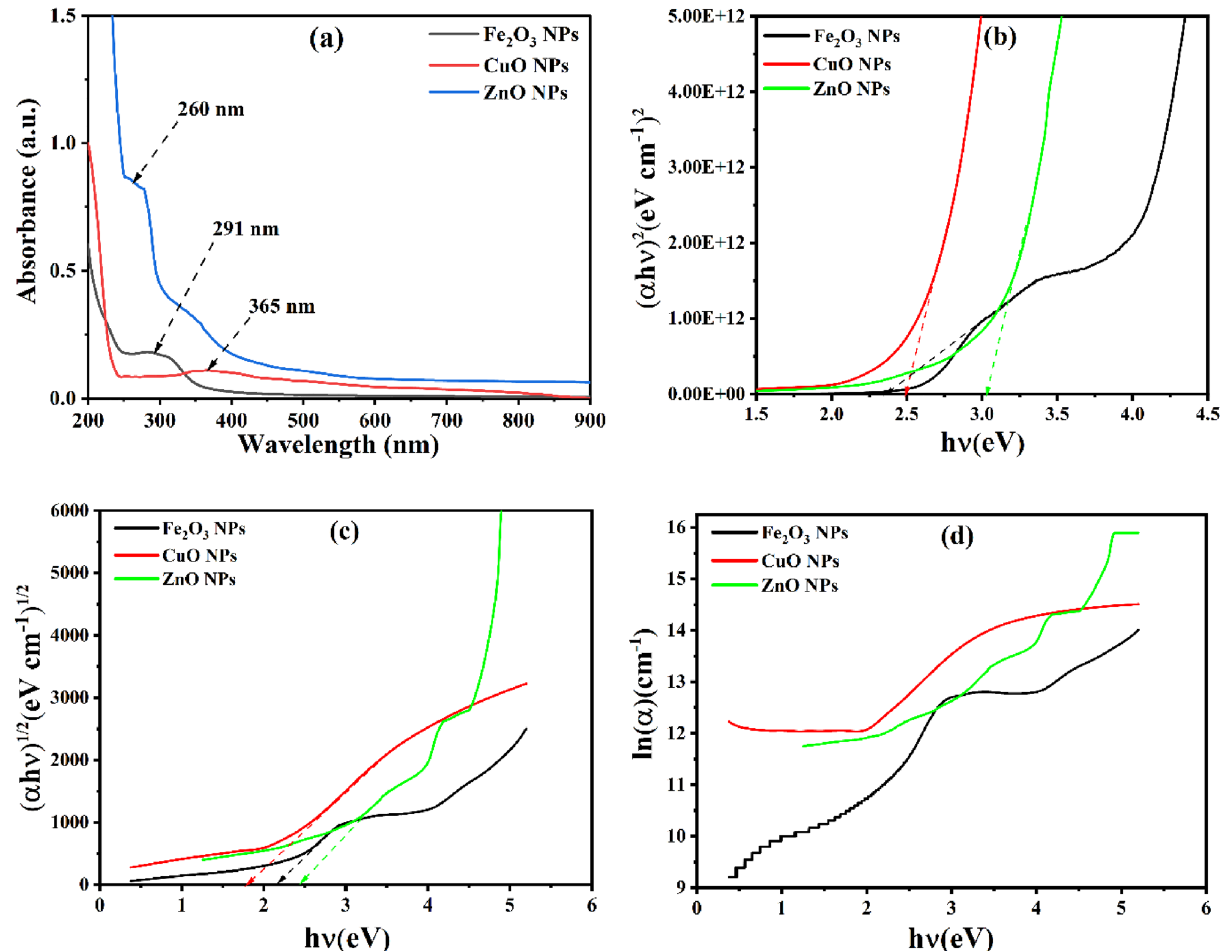
Figure 5. Optical properties of the α-Fe 2 O 3 , CuO, and ZnO NPs: UV–vis spectra ( a ); optical bandgap energy ( b ) ; indirect bandgap energy ( c ) transitions relying on Tauc’s method; ( d ) Urbach energy. Samples